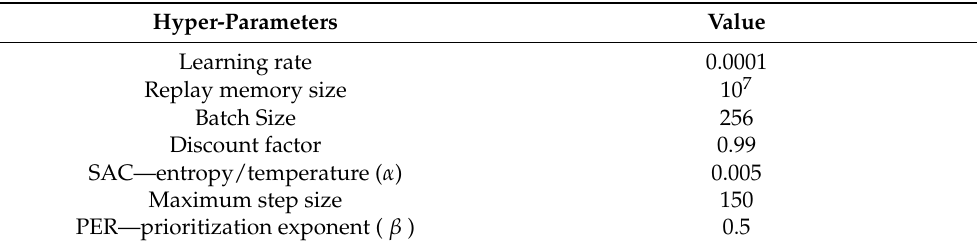
Table 3. List of hyper-parameter values used during